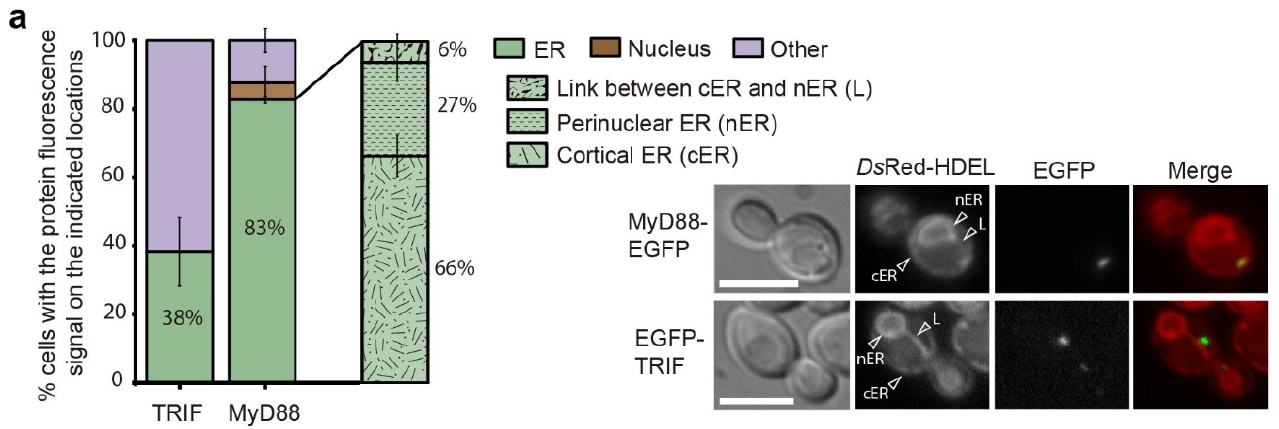
Figure 6. MyD88 is associated to ER-mitochondrial encounter structure (ERMES). ( a ) Differential interference contrast and fluorescence microscopy of yeast cells expressing MyD88-EGFP or EGFP-TRIF in the VHY87 strain, which bears the en- doplasmic reticulum marker DsRed-HDEL (right), and graph (left) displaying the percentage of yeast cells showing MyD88-EGFP and EGFP-TRIF spots colocalizing with the indicated endoplasmic reticulum (ER) locations: cortical ER (cER), perinuclear ER (nER) or the link between both (L), as indicated by arrowheads in the image. Data correspond to means ± standard deviation of three independent transformants ( n > 90). ( b ) Differential interference contrast and fluores- cence microscopy of yeast cells co-expressing MyD88-EGFP or EGFP-TRIF with the mitochondrial marker Ilv6-mCherry on the BY4741 trp1 Δ strain (right), and graph displaying the percentage of yeast cells showing the indicated relative posi- tions between MyD88-EGFP and EGFP-TRIF, and the mitochondria (left). Data correspond to means ± standard deviation of three independent transformants ( n > 90). ( c ) Differential interference contrast and fluorescence microscopy of yeast cells expressing mCherry-MyD88 in the EVY4 and EVY5 strains, that bear the ERMES components Mdm34 and Mmm1, respectively, tagged with mNeonGreen (right). Graph displaying the percentage of cells showing colocalization between MyD88 and each marker (left). Data correspond to means ± standard deviation of three independent transformants ( n > 150). Heterologous production of proteins in yeast cells often results in the formation of unfolded protein aggregates, visible in microscopic images as clusters, inclusions or spots. Such structures are often marked by Hsp104, a chaperone involved in the disassembly of heat shock-induced stress granules (HS-SGs). To add further evidence of MyD88 location